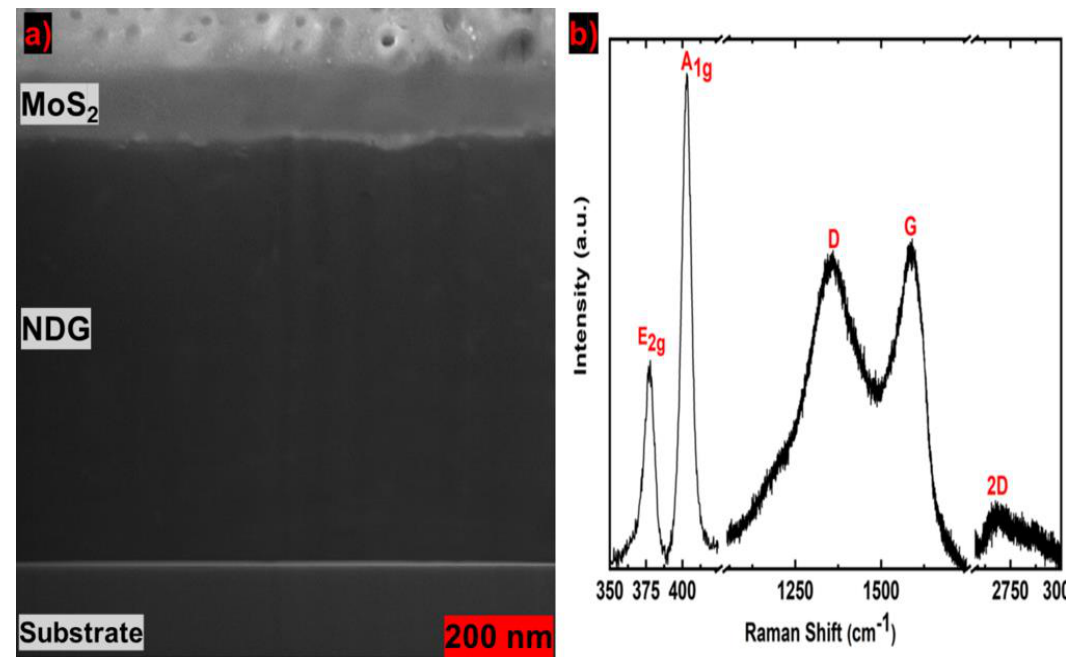
Figure 5. ( a ) FIB-SEM cross-sectional image of the MoS 2 –NDG stack, and ( b ) Raman spectrum of